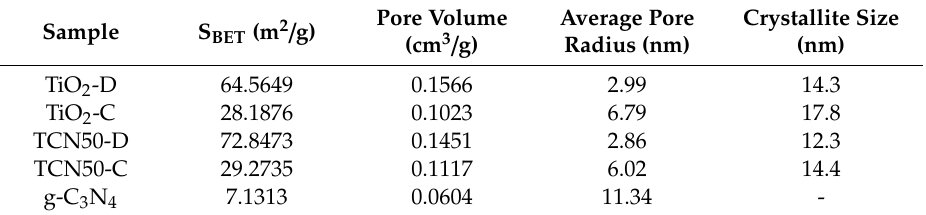
Figure 1. ( a ) XRD patterns of TiO 2 , g-C 3 N 4 and TCN X samples, ( b ) FTIR spectra of TiO 2 , g-C 3 N 4 , TCN50 samples. Table 1. Surface and structural characterization of TiO 2 , g-C 3 N 4 and TCN X composites.